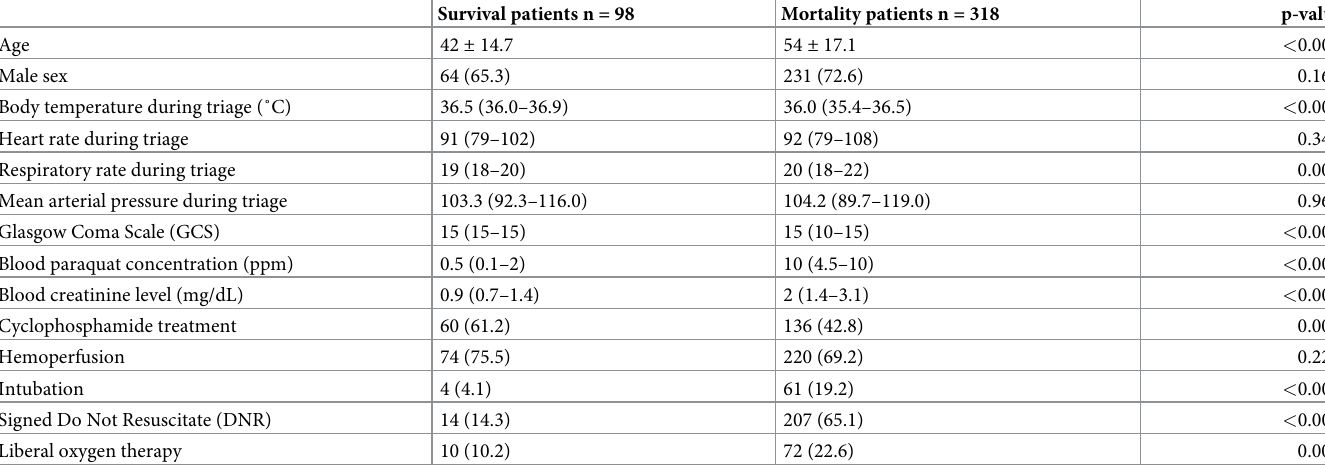
Table 2. Clinical characteristics of patients between survival and overall mortality patients (N =